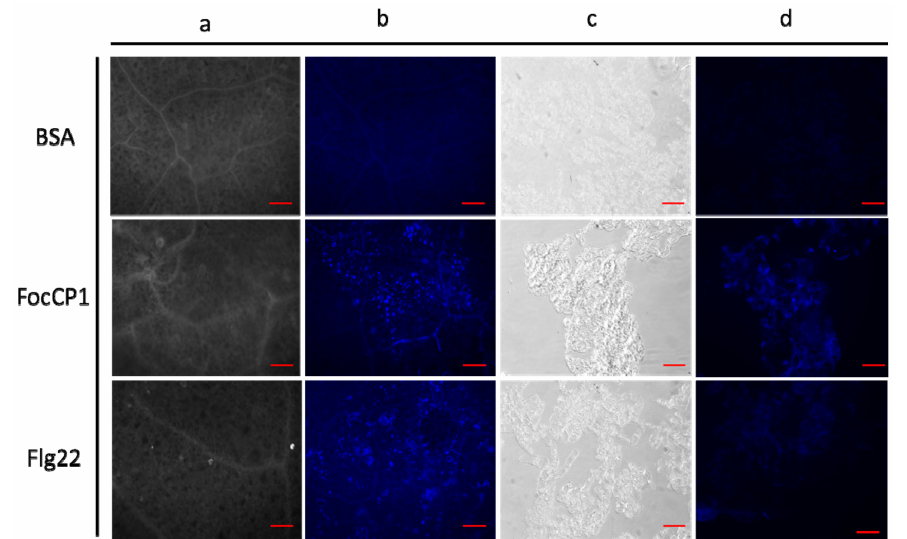
Figure 5. FocCP1 stimulated callose deposition in tobacco leaves and phenolic compounds in tobacco suspension cells. ( a ) Tobacco leaves were observed under bright-field microscopy; ( b ) Tobacco leaves were observed under UV fluorescence microscopy; ( c ) The cell suspension samples were observed under bright-field microscopy; ( d ) The cell suspension samples were observed under UV fluorescence microscopy. The callose deposits and phenolic compounds were photographed in tobacco leaves and suspension cells treated by FocCP1; the positive control Flg22 had an e ff ect on tobacco leaves and suspension cells, while BSA had no e ff ect. Scale bar = 10 µ m. For ( a ) and ( b ), six leaves of three plants were used for each replication. For ( c ) and ( d ), three-tube tobacco suspension cells were used. In all experiments, three independent replicates were